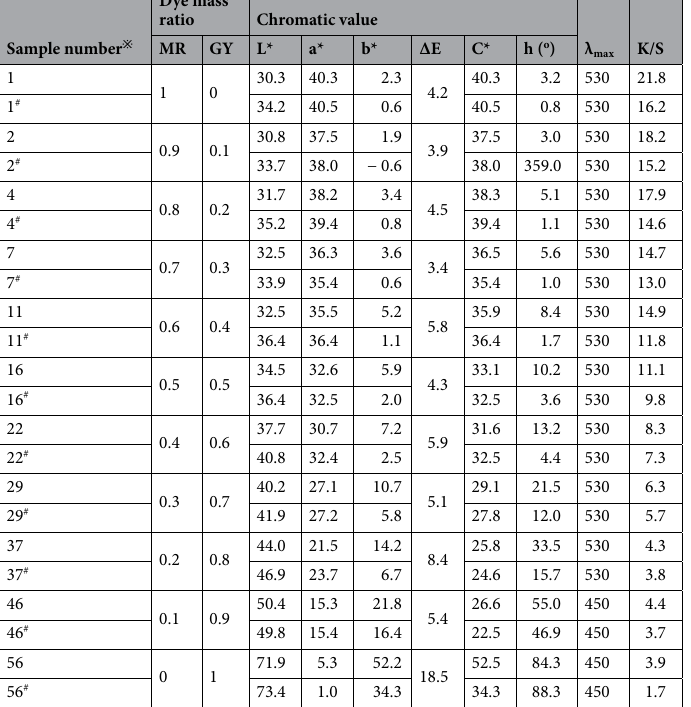
Table 1. Chromatic values of wool yarns dyed with binary mixtures of MR and GY. ※ Sample number without and with # signal indicates the dyed sample before and after soaping,